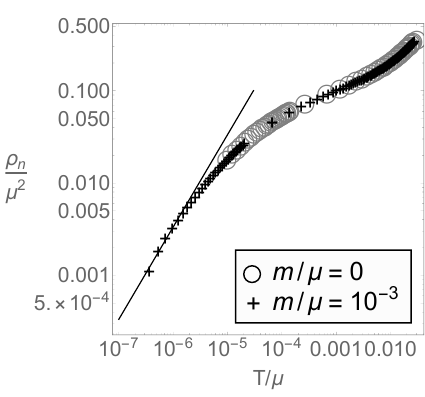
Figure 8 . a = 2 ( z = 1 , θ = − 1 , ξ = 2) : σ 0 ∼ # T − 1 2 × exp ρ n ∼ # T 4 , ρ 2